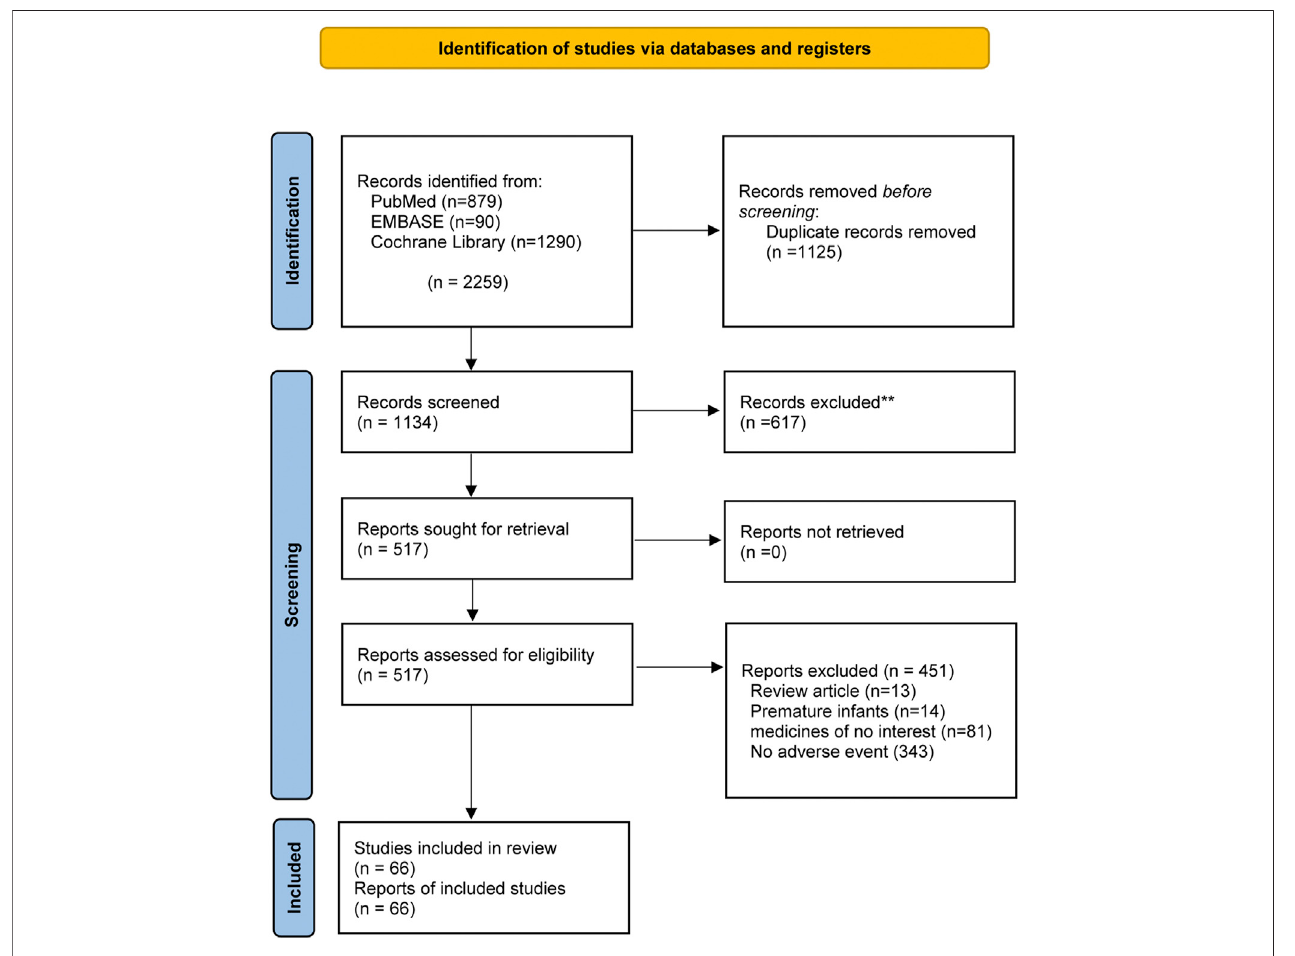
FIGURE 1 | Flowchart of study selection.